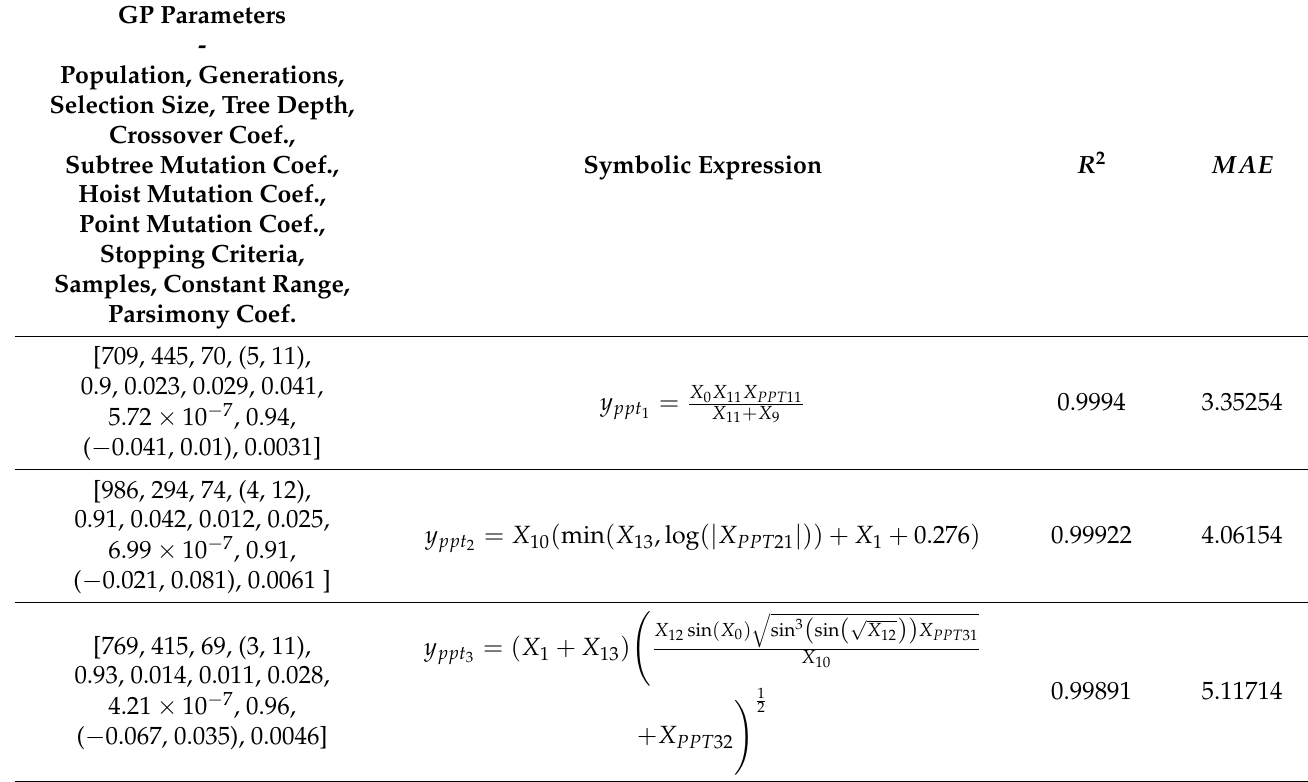
Table 11. Three best symbolic expressions for port propeller torque estimation without decay state coefficients with corresponding R 2 and MAE